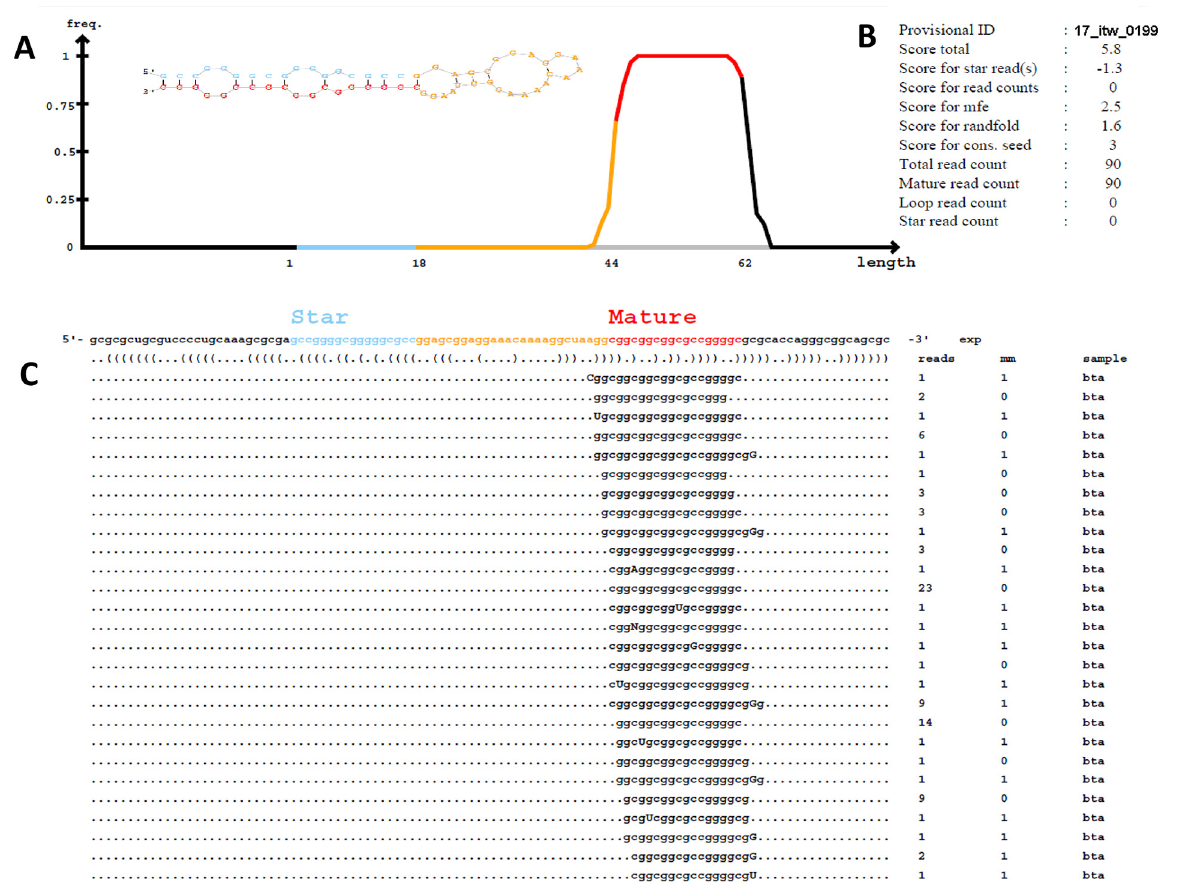
Fig 3. Graphic illustration of a representative predicted novel miRNA by miRDeep2. The primary miRNA hairpin with both mature and star miRNAs highlighted with red and blue colors, respectively ( A ). MiRDeep2 scores and provisional ID are shown ( B ). The consensus matured miRNA sequence and other isomiRs and their corresponding read counts are indicated. Mismatched nucleotides of isomiRs with the miRNAs hairpin are written in capital letter ( C